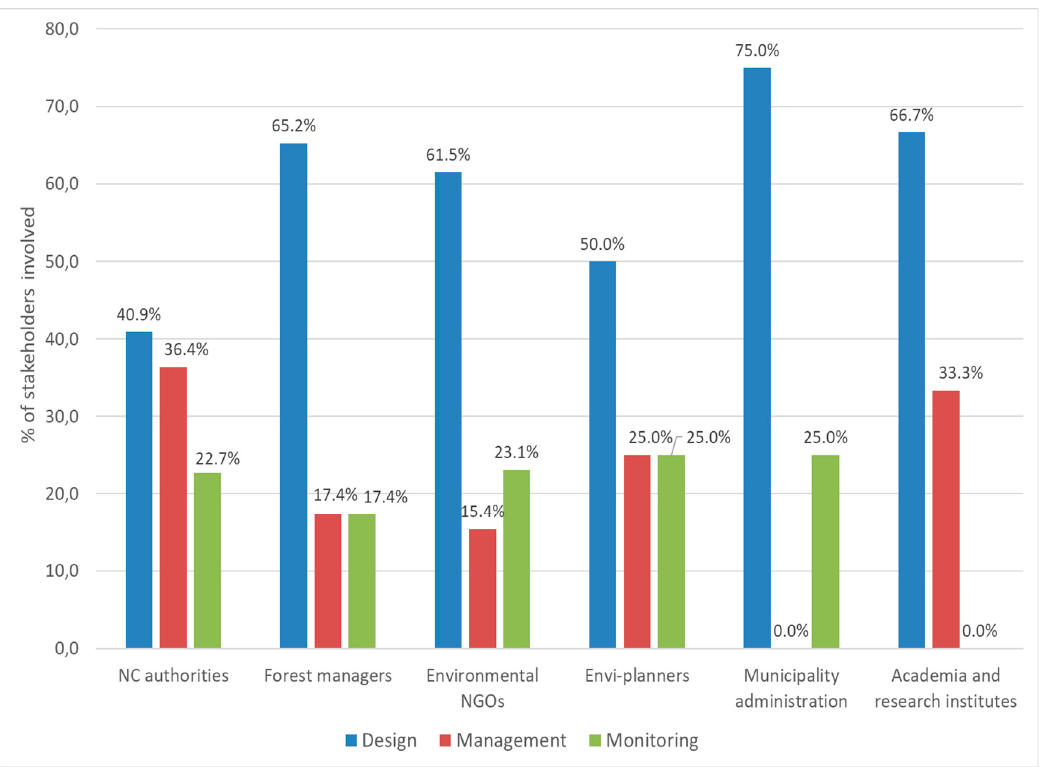
Figure 2. Stakeholders involved (%) in the implementation phases of the Natura 2000 network by group of interest.